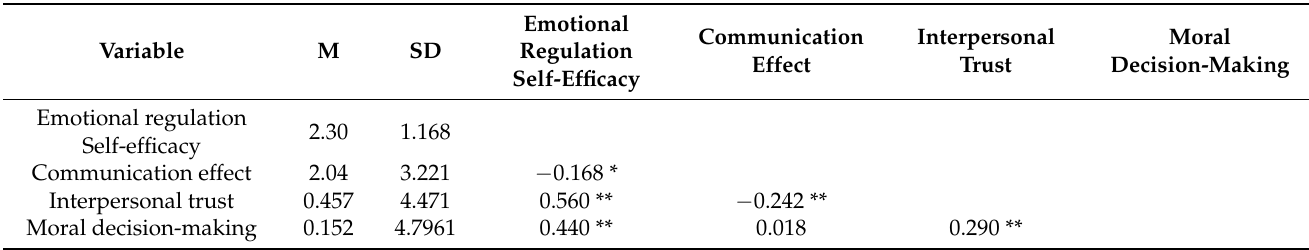
Table 3. Mean, standard deviation, and correlation coefficient ( p * < 0.05, p ** < 0.01).